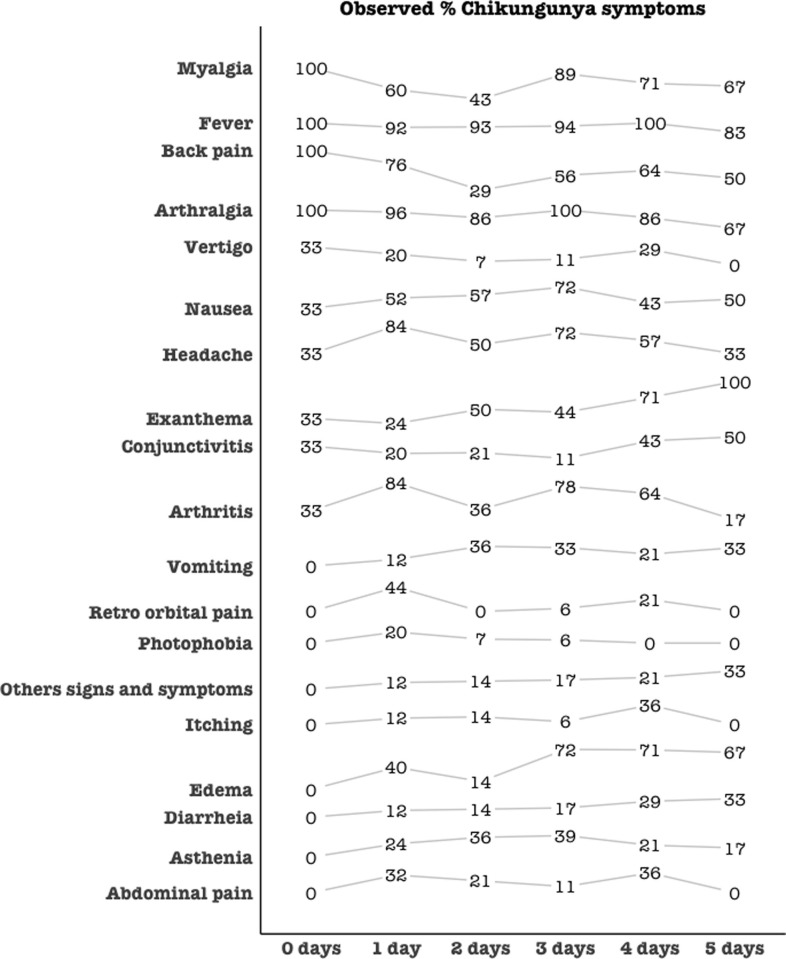
Chikungunya signs and symptoms.Temporal sequence of clinical signs and symptoms in acute chikungunya infection cases.